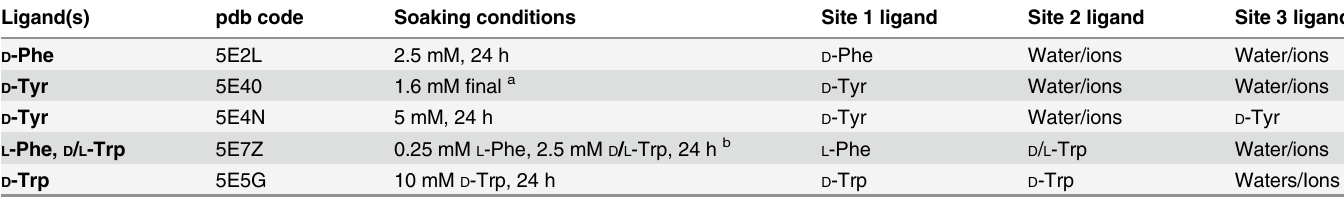
Table 1. Summary of soaking conditions and ligand occupancy for crystals soaked in D -amino acids.